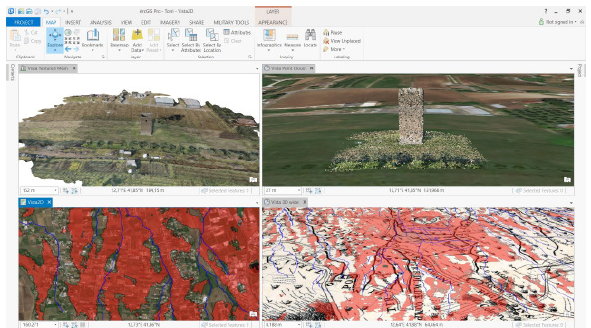
Figure 9. 2D/3D Geodatabase management with ArcGIS